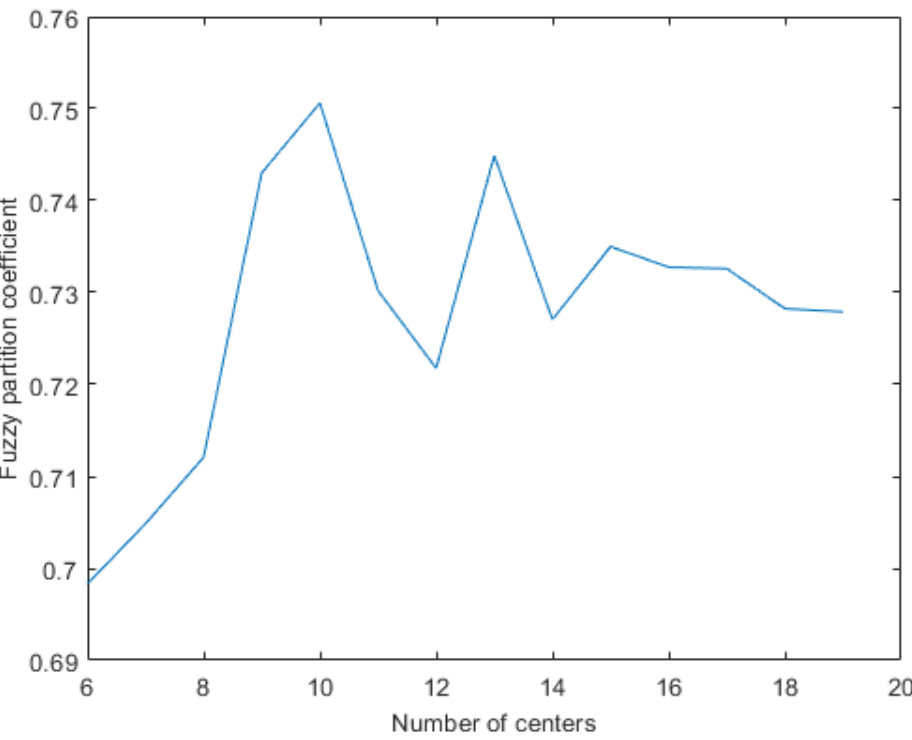
Figure 6. Fuzzy partition coefficient versus number of